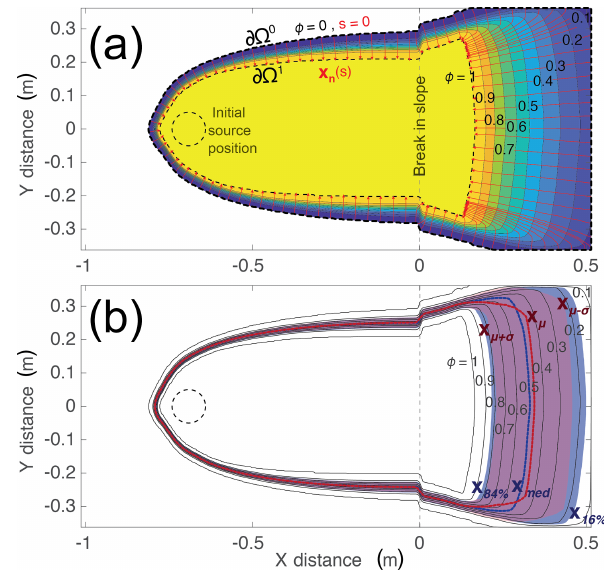
Figure 3. (a) PHM contours for a Mohr–Coulomb (MC) flow on an inclined plane with integral curves x n (s) (red) connecting points on ∂(cid:127) 0 to points on ∂(cid:127) 1 as defined in the text. (b) Mean ( x µ , red curve) and median ( x med , blue curve) flow boundary sets as well as regions within 1 standard deviation from the mean (red) and containing 68% of the possible flow boundaries around the median